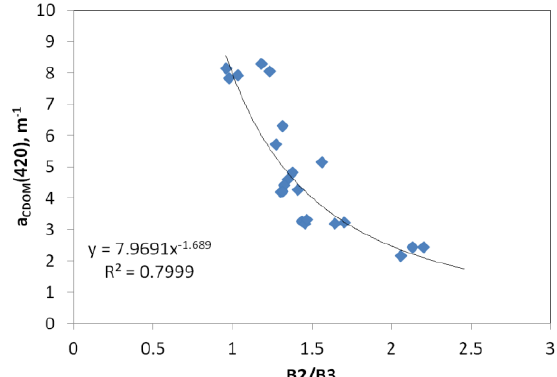
Figure 2. Correlation between in situ measured absorption of CDOM at 420 nm and B2/B3 ratio calculated from Ramses reflectance